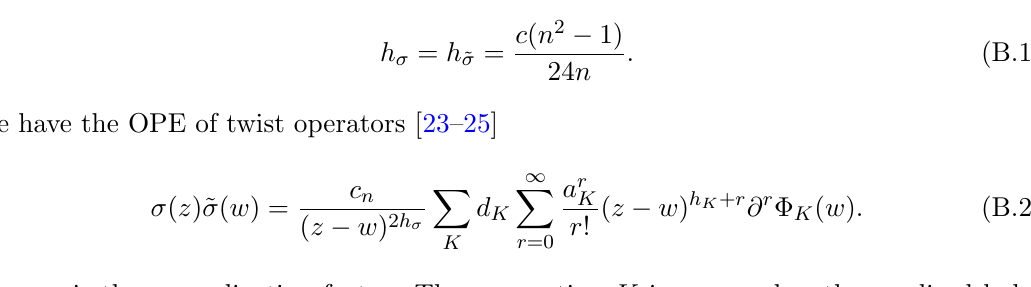
and OPE coe(cid:14)cients d K